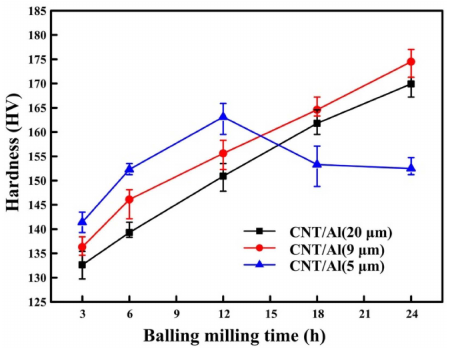
Figure 11. The effect on micro-hardness of the sintered composites for increasing ball-milling time and different initial aluminum alloy particle